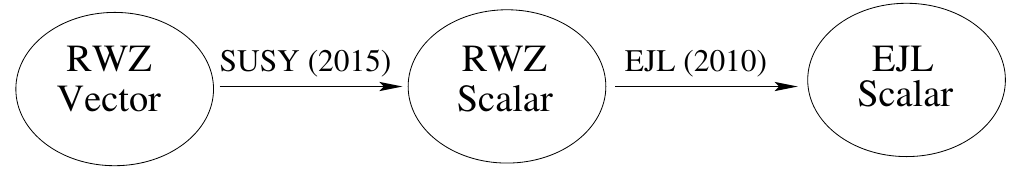
Figure 1 . Schematic representation of the connection between the Regge-Wheeler-Zerilli (RWZ) and Edalati-Jottar-Leigh (EJL)